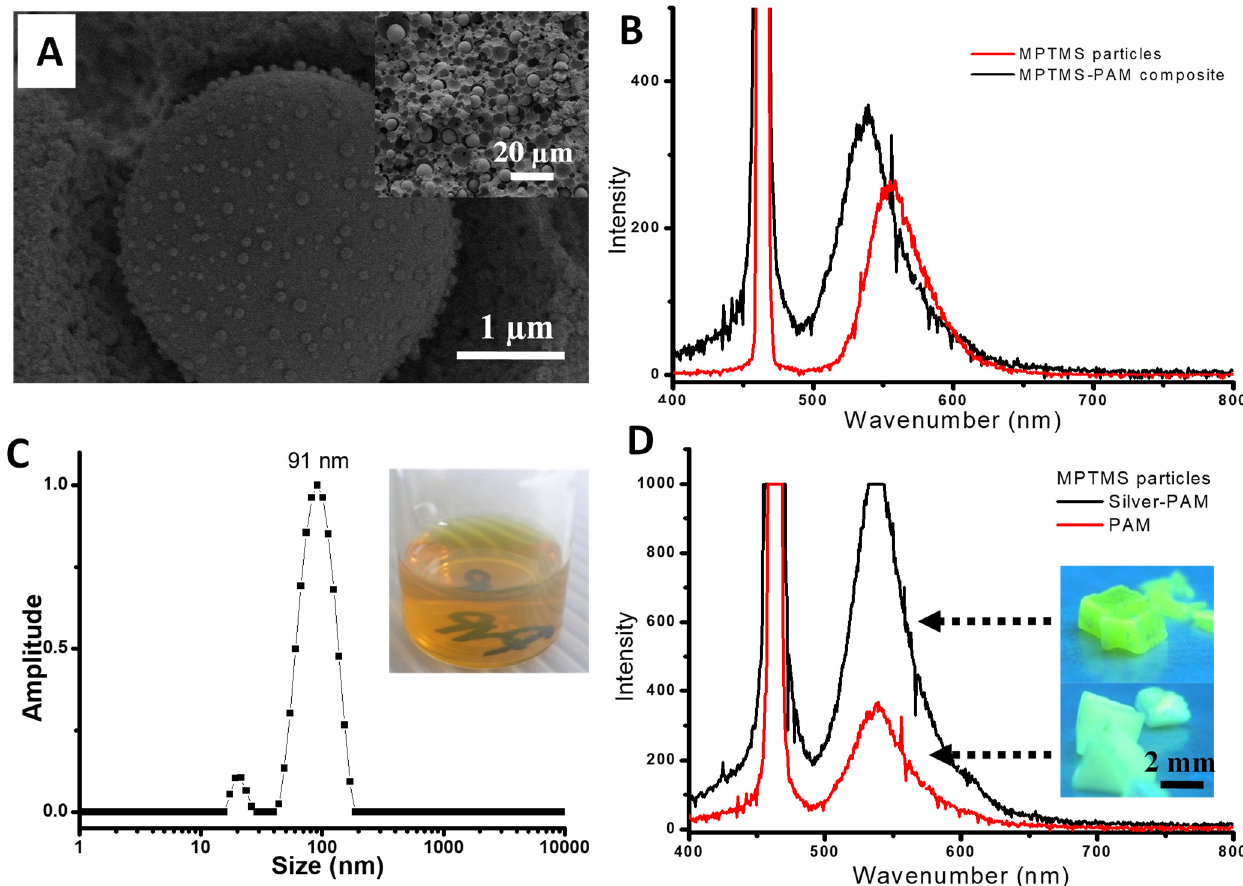
Figure 9. ( A ) Fluorescent silica microspheres were synthesised inside the PAM monolith with the inset showing the distribution of spheres within the scaffold. ( B ) Emission spectra of MPTMS particles and MPTMS silica–PAM composites. ( C ) DLS plot for the hydrothermally prepared silver nanoparticles stabilised with PVP 360K with the inset showing a photo of the Ag nanoparticles suspension. ( D ) Emission spectra of MPTMS microspheres synthesised inside PAM and Ag/PAM monoliths, with the inset showing the photos of the MPTMS silica–PAM and MPTMS silica–Ag/PAM monoliths under the 365 nm UV lamp .